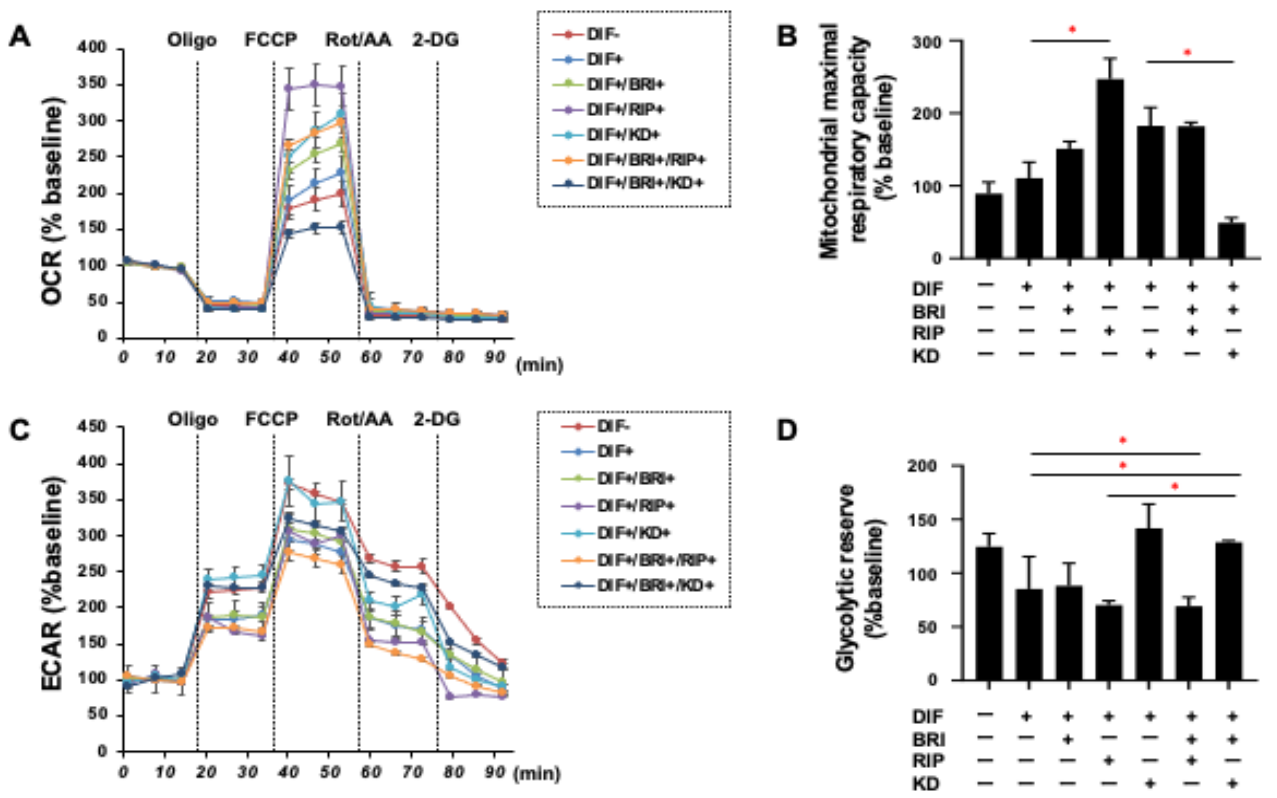
Figure 3. Real-time analysis of cellular metabolism of 2D-cultured 3T3-L1 cells. The 3T3-L1 cells were 2D-cultured under several conditions: preadipocytes of 3T3-L1 cells (DIF−) and their adipo- genic differentiation (DIF+) with or without 10 µM ripasudil (Rip) or KD025, and/or BRI were sub- jected to a real-time metabolic function analysis using a Seahorse XFe96 Bioanalyzer. ( A , B ) Basal OCR and ECAR were measured, and thereafter they were further measured after subsequent sup- plementation with oligomycin (complex V inhibitor), FCCP (a protonphore), and rotenone/antimy- cin A (complex I/III inhibitors) and 2DG (hexokinase inhibitor). ( C , D ) Basal respiration is calculated by subtracting OCR with rotenone/antimycin A from OCR at baseline. ATP-linked respiration was defined by the difference in OCR after the addition of oligomycin. Maximal respiration was calcu- lated by subtracting OCR with rotenone/antimycin A from OCR with FCCP. Basal ECAR and Gly- colytic capacity were defined by subtracting ECAR with 2-DG from ECAR at baseline and ECAR with oligomycin, respectively. (E) Energy map for cells among treatment groups. All experiments were performed in triplicate using fresh preparations ( n = 5). Data are presented as the mean ± the standard error of the mean (SEM). * p < 0.05 (ANOVA followed by a Tukey’s multiple comparison test).